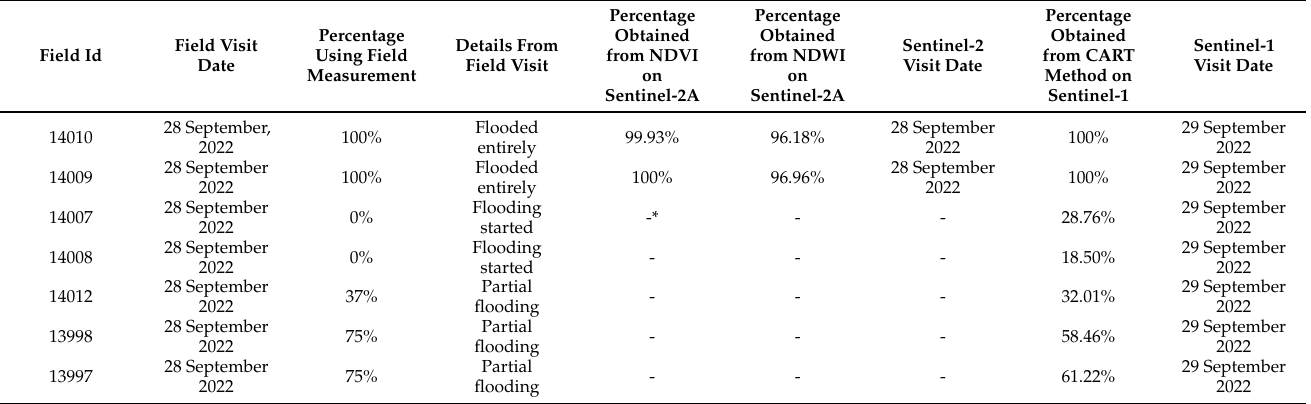
Table 9. Percentage of the flooded area obtained from field verification as well as our proposed method used in satellite images.